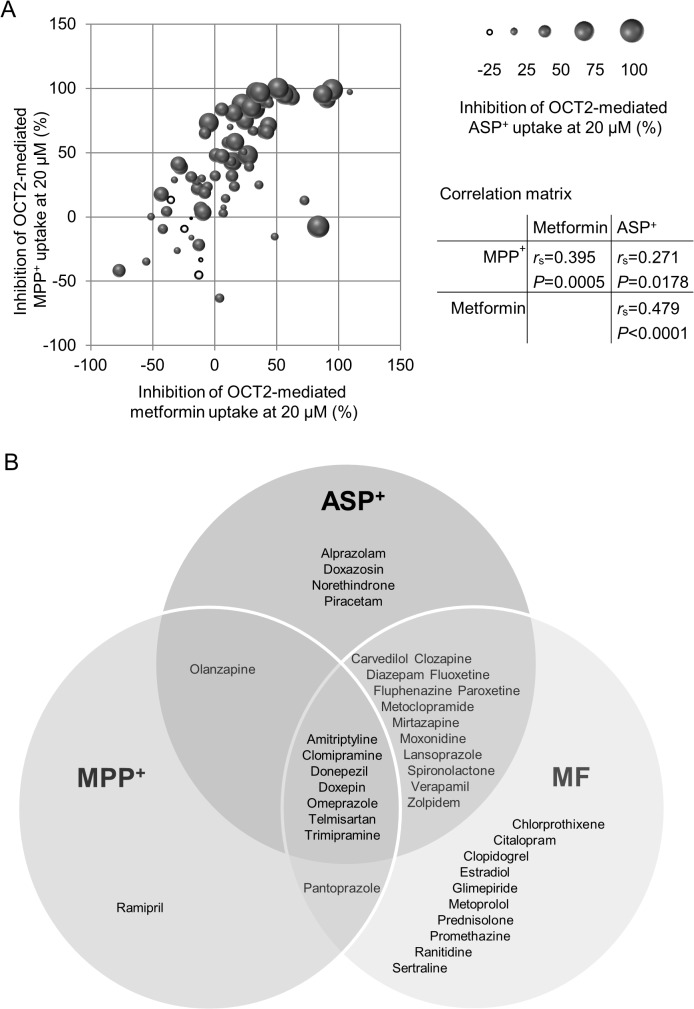
Correlation between inhibition of OCT2-mediated metformin, MPP+, and ASP+ uptake in HEK-OCT2 cells.(A) Shown are drugs which were tested for each of the three substrates (n = 75). Drugs were tested at 20 μM. The size of the balls represents the inhibition of ASP+ uptake. Black balls, positive values; white balls, negative values. ASP+ data are from Kido et al. (2011). (B) Venn diagram showing unique and common / overlapping inhibitors of metformin, MPP+, and ASP+ uptake, respectively, by the human OCT2 transporter. Shown are only those drugs which were tested for each of the three substrates (n = 75) and which inhibit uptake of the respective substrate by more than 50%.